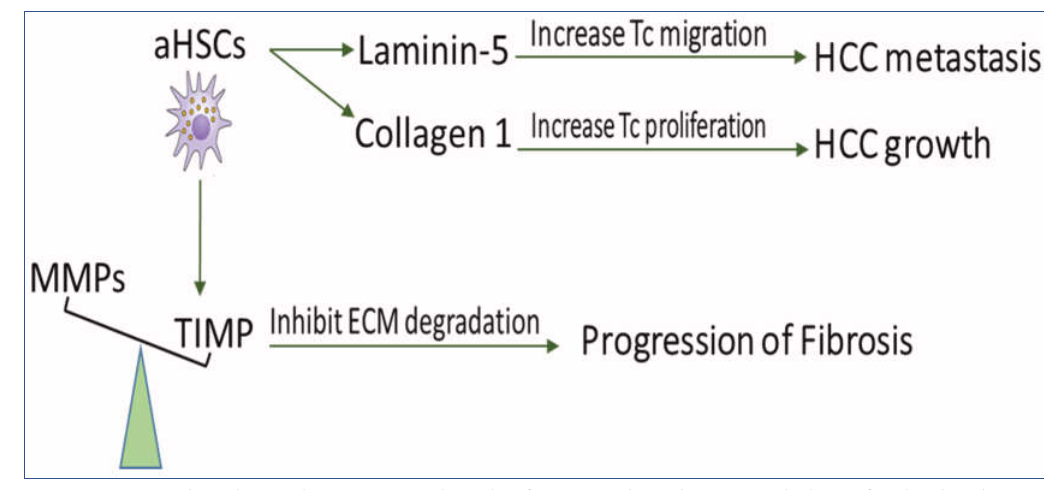
Figure 2. The scheme demonstrates the role of HSCs in disturbing ECM balance for the development of fibrosis and HCC. aHSCs express TIMP glycoproteins which inhibit MMP-mediated degradation of ECM and, therefore, prevent fibrosis regression. They also secrete collagen I, which increases tumor cell proliferation and produces Ln-5, which promotes tumor cell migration. MMPs: matrix metalloproteinases, TIMPs: tissue inhibitors of MMP, aHSCs: activated hepatic stellate cells, HCC: hepatocellular carcinoma, ECM: extracellular matrix, and TC: tumor